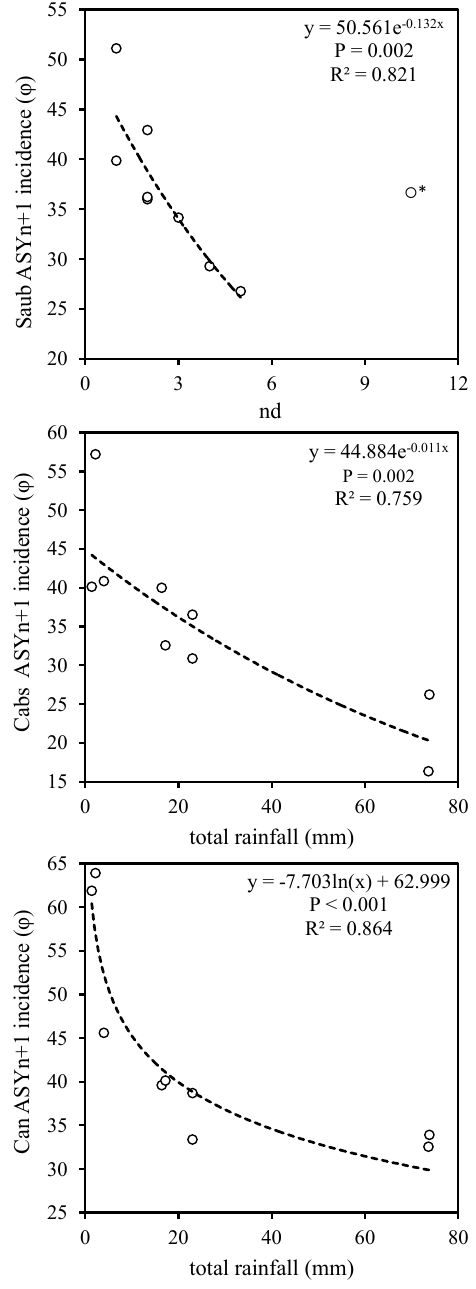
Figure 5. Regressions between arcsin-square root trans- formed (degrees ϕ) annual incidence of Sauvignon blanc (Saub), Cabernet sauvignon (Cabs) and Cannonau (Can) plants showing GLSD foliar symptoms in year n but symp- tomless in year n+1 (ASY n+1) and rainy parameters (nd = number of rainy days; total rainfall) in the period June – July of the symptomless year. Data point marked with as- terisk was excluded by the analysis.